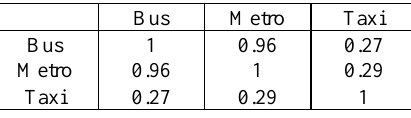
Table 5. Temporal correlation coefficients